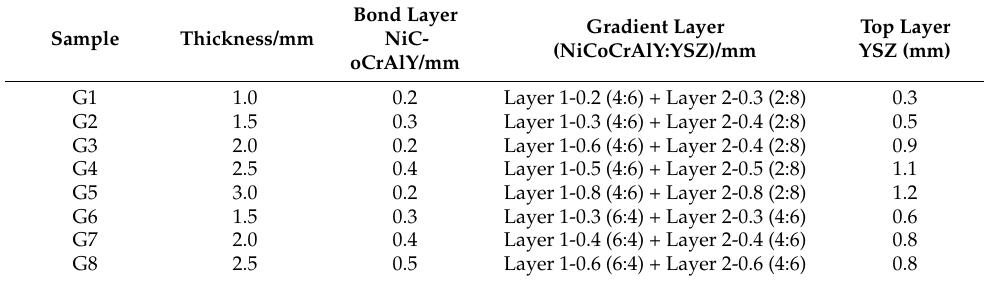
Table 1. The different gradient structures of samples with millimeter level